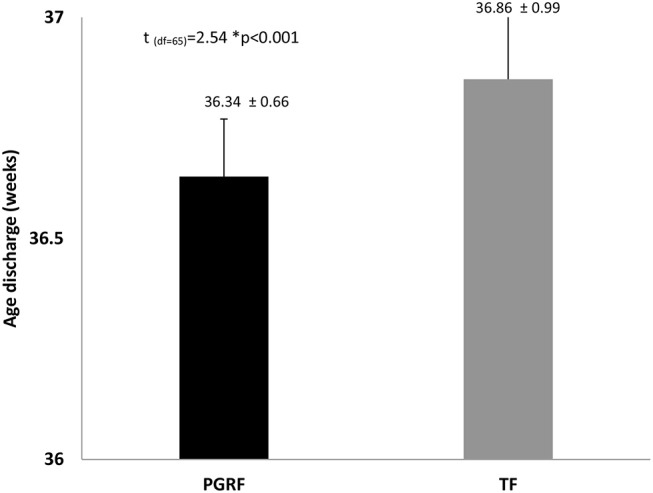
Age at discharge among the study groups. Data are presented as mean ± standard deviation. Statistical analysis was based on independent sample t-test. PGRF, parental guided responsive feeding; TF, traditional feeding.